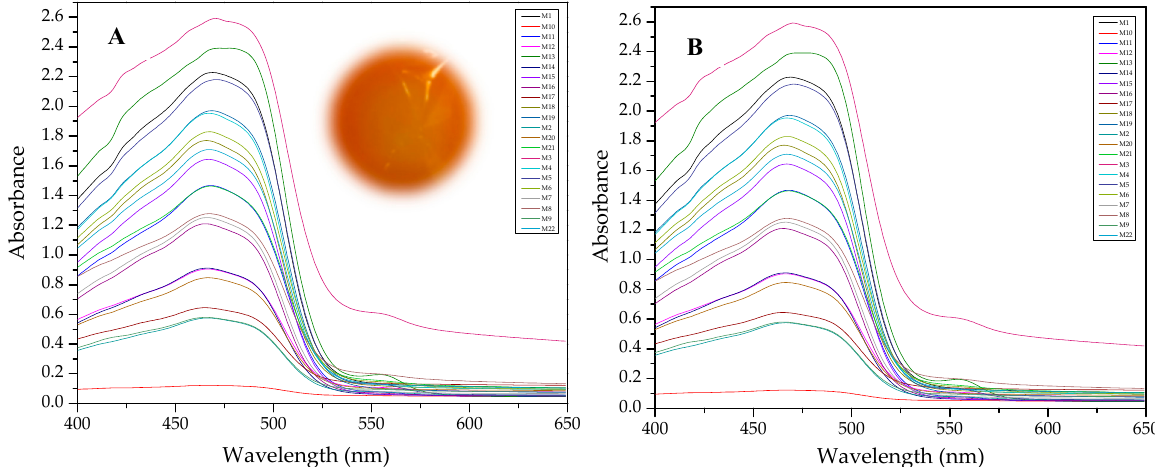
Figure 7. Visible spectra and appearance of the membranes before ( A ) and after ( B ) complexation for the system PAN–Cd(II).